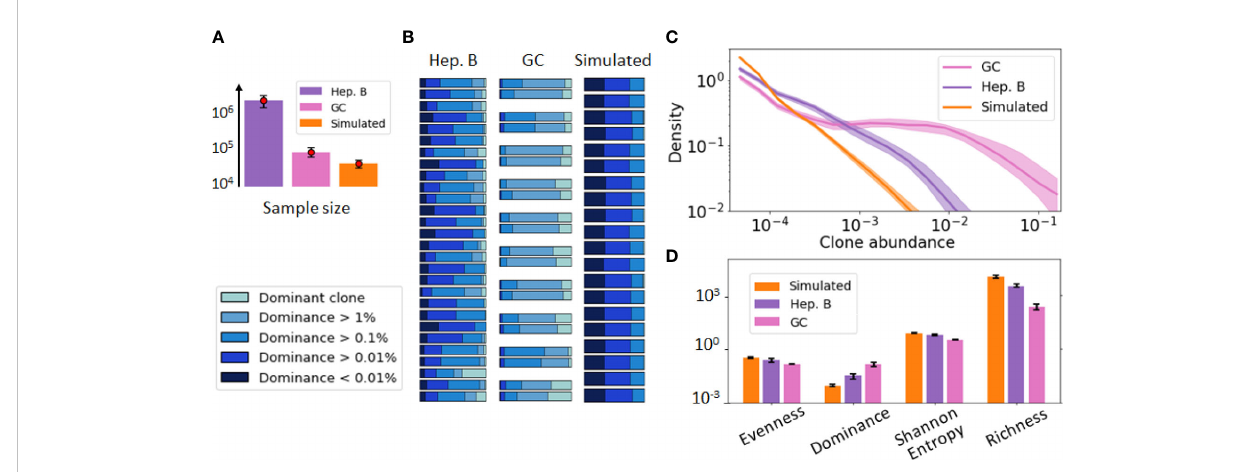
FIGURE 1 Visualization of the B-cell repertoires dataset used in our study, including a germinal center (GC) [36], hepatitis B (Heb.B) [5] and simulated [27] datasets. In this fi gure, clones have been identi fi ed according to previous conventions [50, 19] (shared V, J gene segments and similar CDR3s). (A) Average sample size of the three datasets, where the error bar represents one standard deviation. (B) Stacked histogram depicting the proportion of sequences belonging to the dominant clone, expanded clones (dominance > 1% excluding the dominant one), and non-expanded clones (dominance < 1%) in each sample of each dataset. Replicate samples in the GC repertoire dataset are grouped together. (C) Clonal abundance distribution in the three repertoires after normalizing the 3 datasets to account for sample differences. The solid line represents the distribution averaged over all samples and the shaded area indicates one standard deviation. (D) Computed diversity indices for each dataset of the previous fi gure. The error bar represents one standard